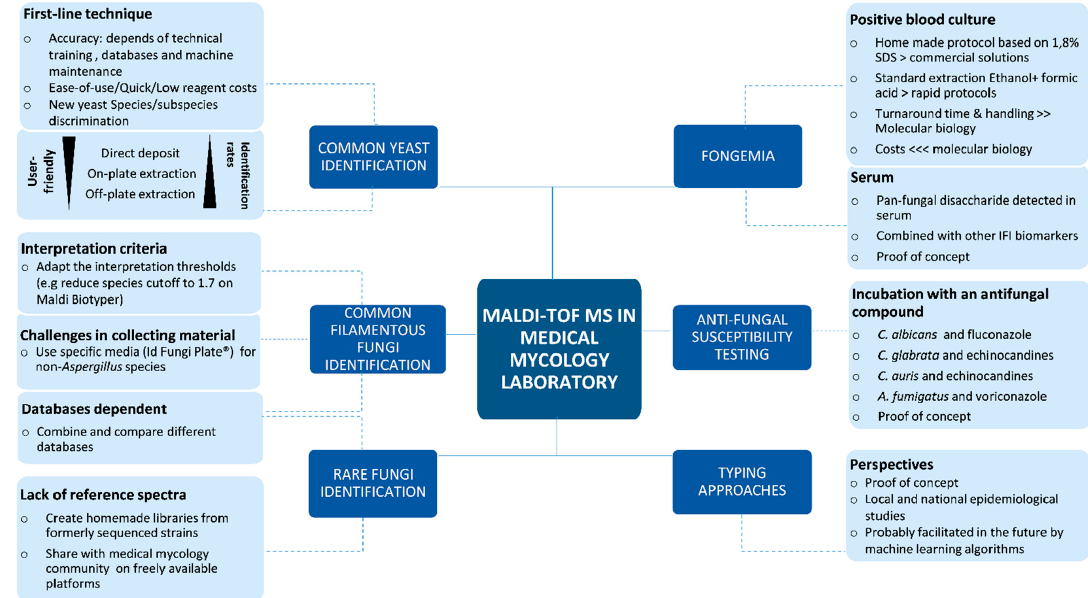
Figure 2. Mind map resuming the present and possible future applications, limits and solutions of MALDI-TOF MS in the field of routine use in a medical mycology laboratory.